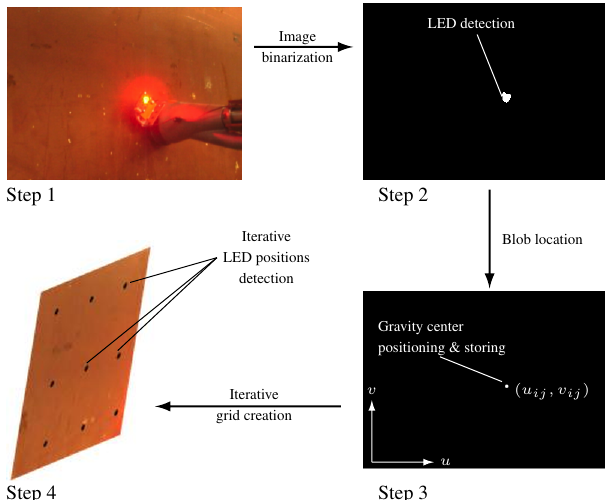
Figure 10. Grid creation using a high brightness LED. The automated system controls the cleaning head, with a high brightness LED placed on it, to position it on each point of the pre-established grid. When the desired ( X; Y ) position on the grid is achieved, the automated system moves the cleaning head on the Z axis until the hull surface is reached. Then, the LED is switched on, and the vision system acquires an image (step 1). A binarization using a dynamic threshold is performed over the acquired image (step 2). The output of the image binarization is the set of pixels where the LED position is located on the hull surface. A next step (step 3) is performed to find the gravity center of the set of points of the LED position. This point will be labeled as the grid point on the hull surface associated to the equivalent point on the XYZ Table. After performing these steps iteratively over all the ( X; Y ) grid points of the XYZ Table (step 4), the full equivalent grid points on the camera plane are obtained. These transformed points will be the key points for the warping